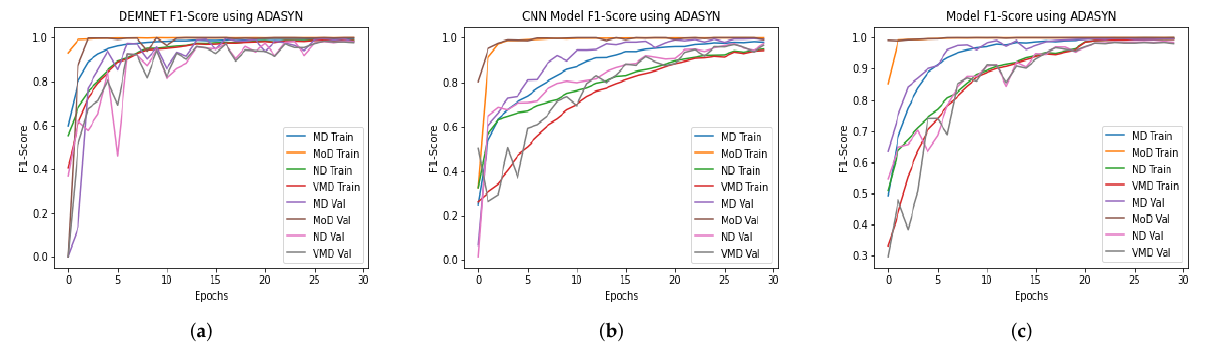
Figure 15. F1-Score Comparison of DEMNET, CNN Model, and DAD-Net using ADASYN. ( a ) DEM- NET; ( b ) CNN Model; ( c ) Proposed